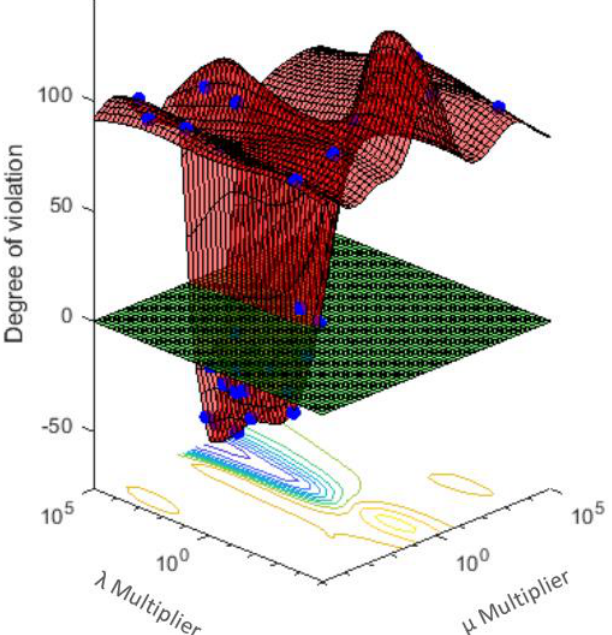
Figure 7. Power-balance violation degree during a variational Bayes optimization loop.